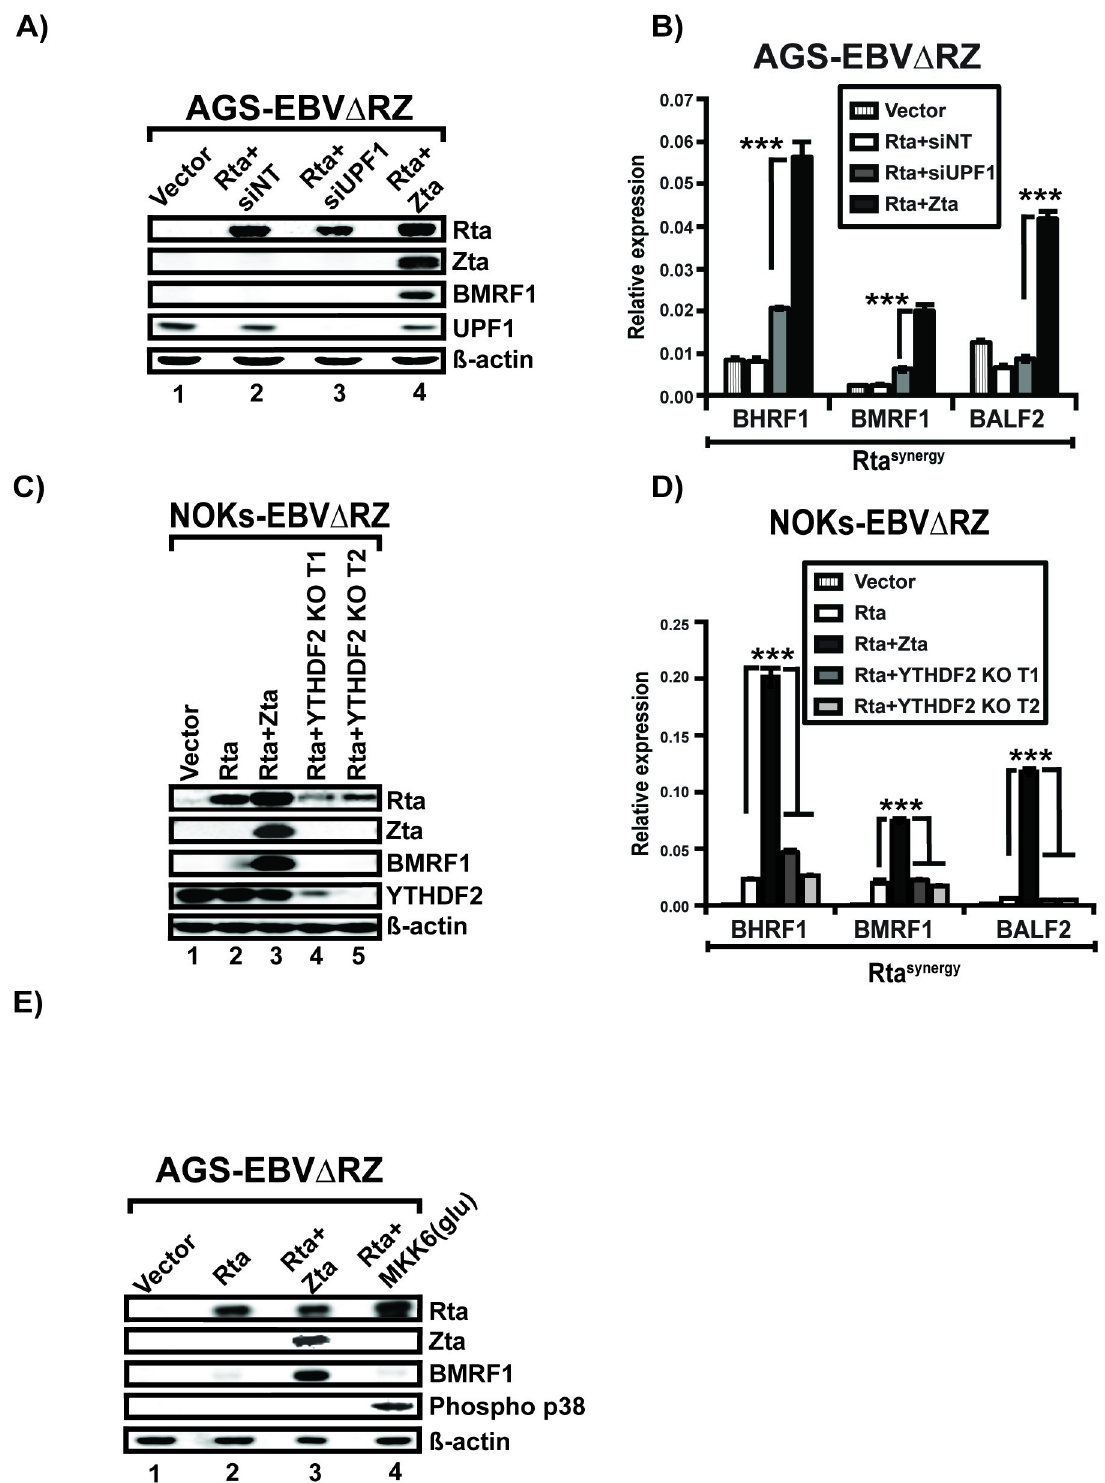
Fig 9. Zta does not affect RNA stability of the early lytic Rta synergy transcripts. (A) Western blots of AGS-EBV Δ RZ transfected with empty vector, Rta with non-targeting siRNA vector (Rta+siNT), Rta with UPF1 siRNA vector (Rta+siUPF1), or Rta with Zta (Rta+Zta) and probed with the indicated antibodies. (B) Real-time qPCR quantification from the same cells described in (A) showing expression levels of the indicated early Rta synergy transcripts. (C) Western blot images of NOKs-EBV Δ RZ cells harboring either wild-type YTHDF2